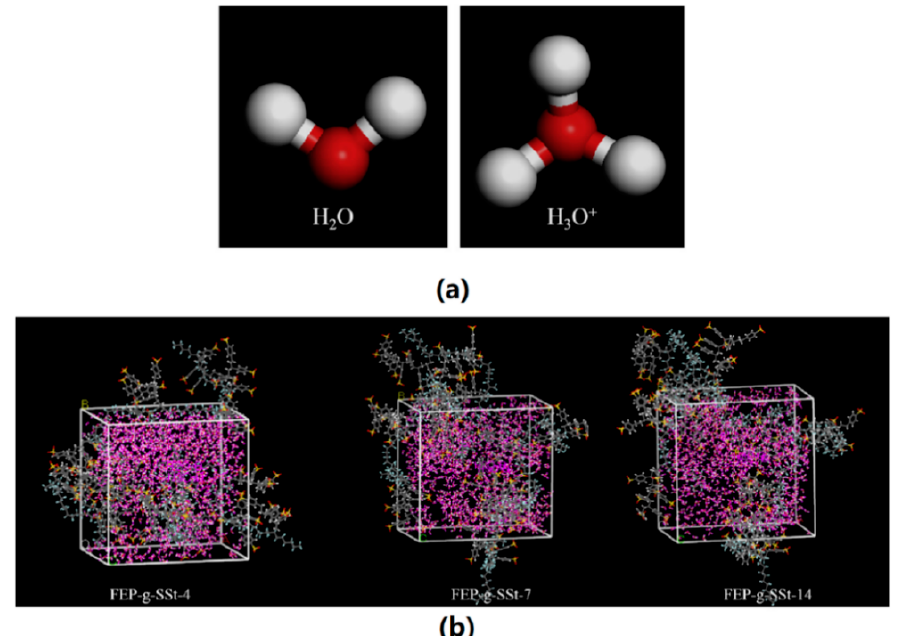
Figure 11. MD simulations for the migration behavior of water molecules and ions in PEM; ( a ) water molecule and ion optimization; ( b ) final snapshots of FEP-g-SSt-n ( n = 14, 7, 4) films obtained by MD simulations [93].